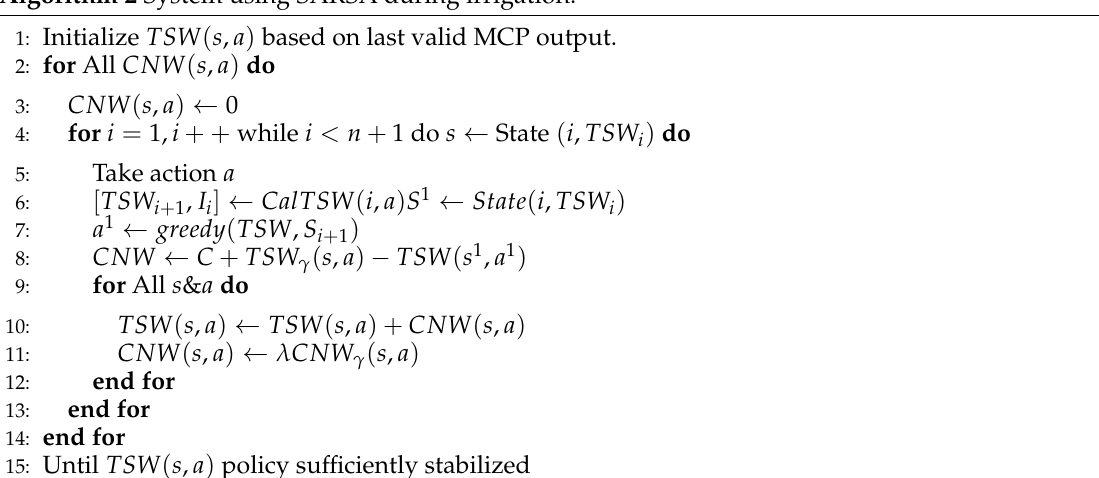
Algorithm 2 System using SARSA during